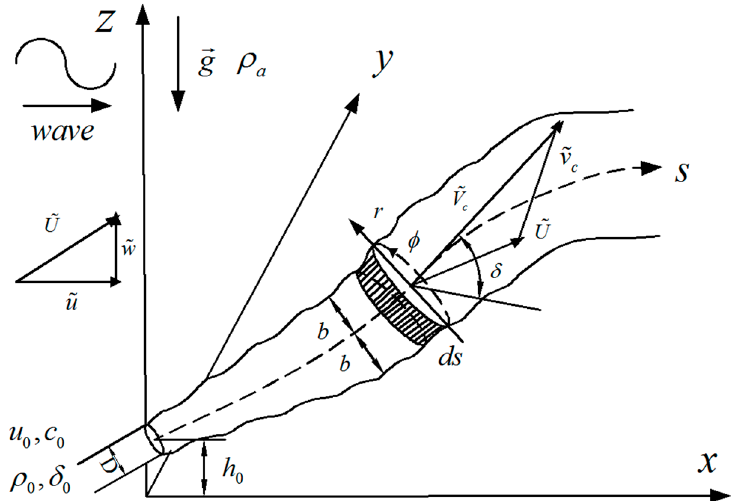
Figure 1. Definition diagram for a turbulent jet discharge into ambient flow with global and local coordinate system, respectively.